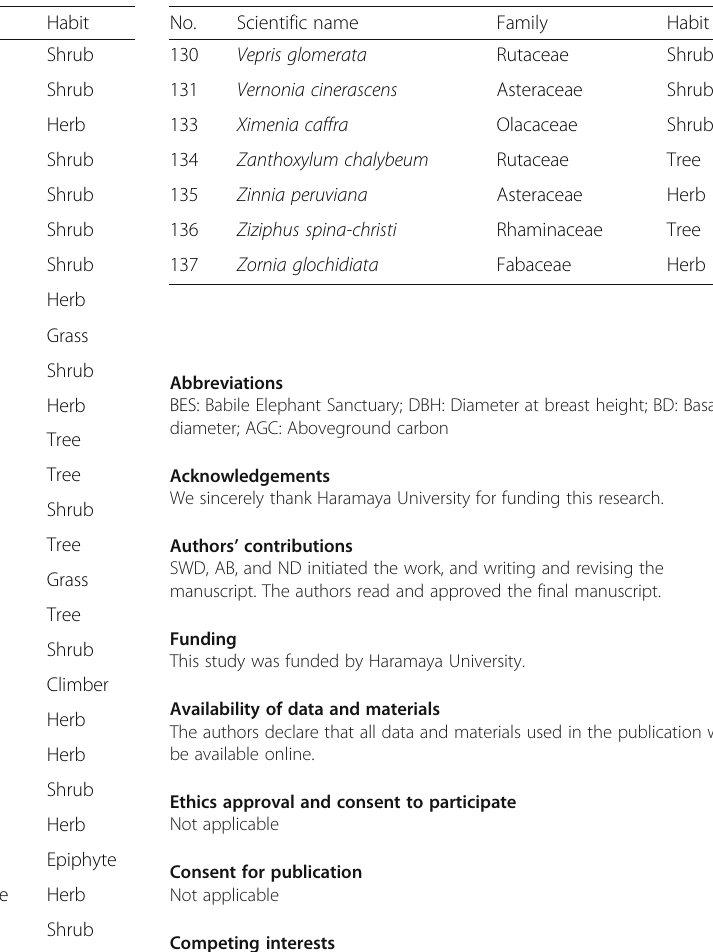
Table 5 List of plant species identified in the study area